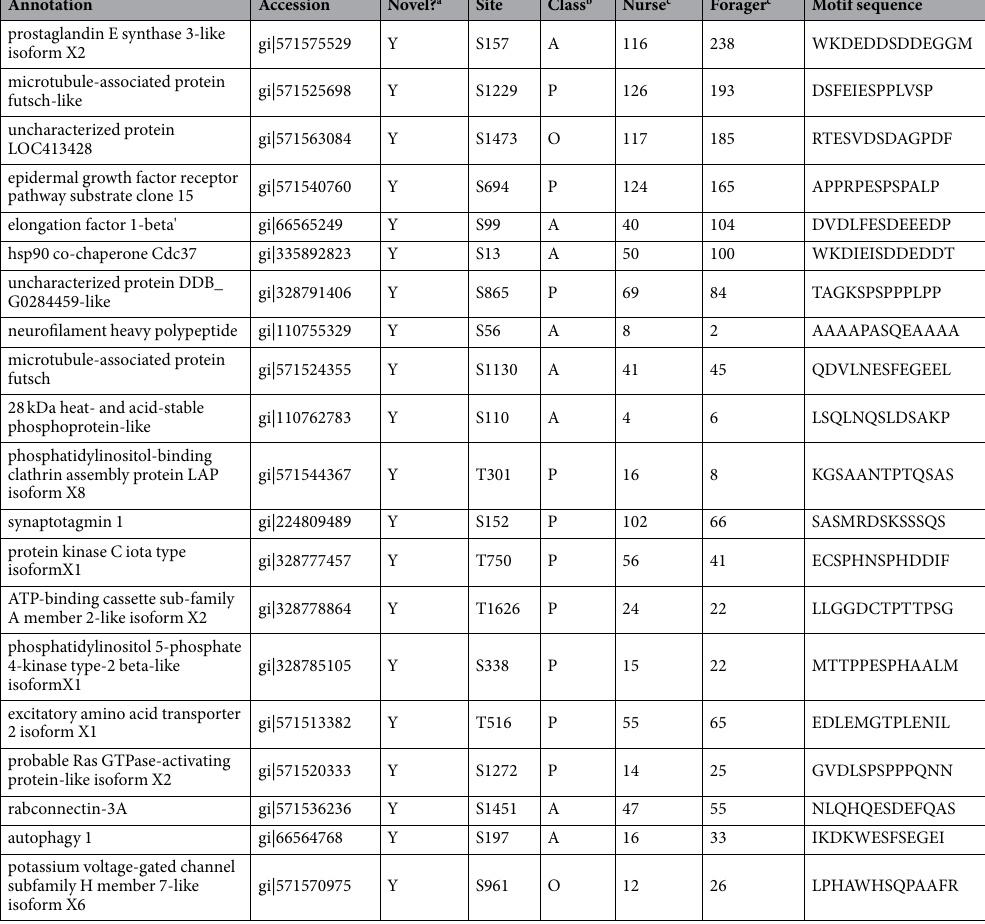
Table 2. Abundant “Common” phosphosites in honeybee brain at the two ages as determined by spectral counts. Selected abundant phosphosites that were found in the brain of nurse and forager bees ( Apis mellifera L .), listed by protein. See also Supplemental Table 2 and 3. a Novel site is decided according to whether the site has been reported with protein post-translational modifications in Apis mellifera . b Site class is assigned by a decision tree algorithm: A = acidic; B = basic; O = other; P = proline-directed; T = tyrosine. c Number of spectral counts in a protein of nurse and forager